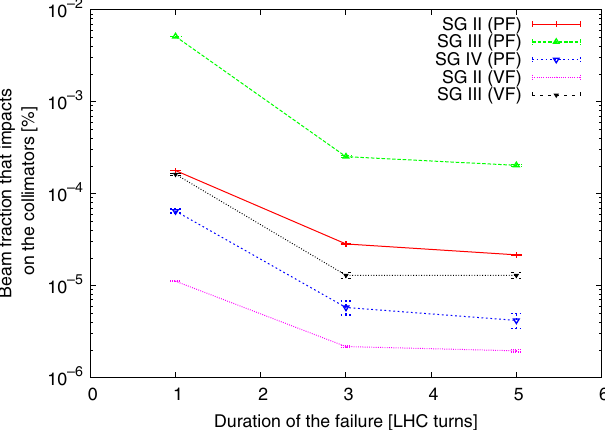
FIG. 7. Beam fraction that impacts on the collimators for the PF and VF cases considering the SG distributions. No impacts are produced in the SG IV for VF cases and in the SG I for both failure cases.